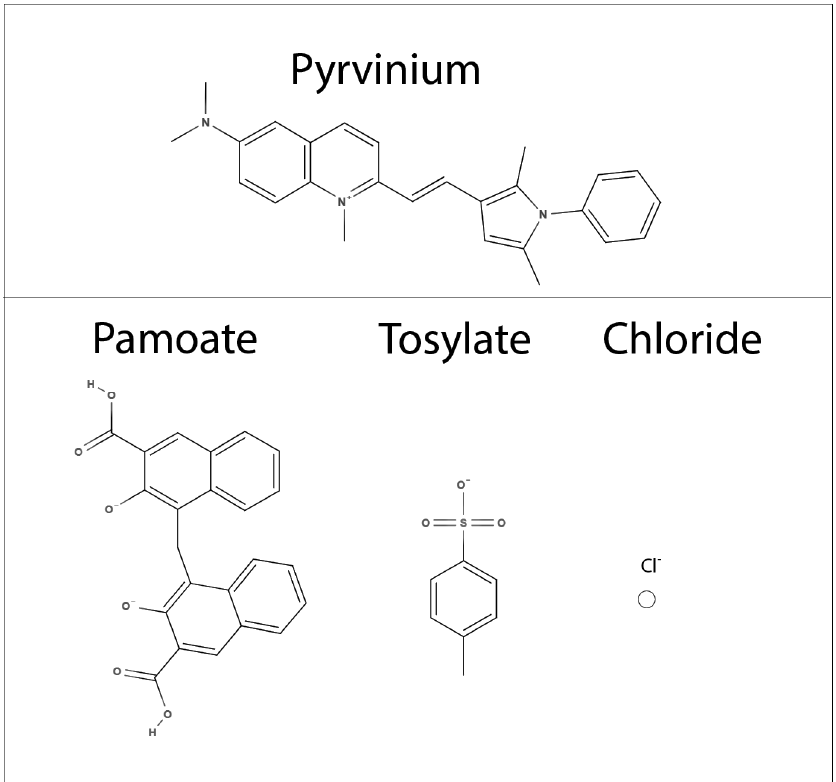
Figure 1. Chemical structure of pyrvinium with its salts counterions: pamoate (embonate), tosylate, and chloride.